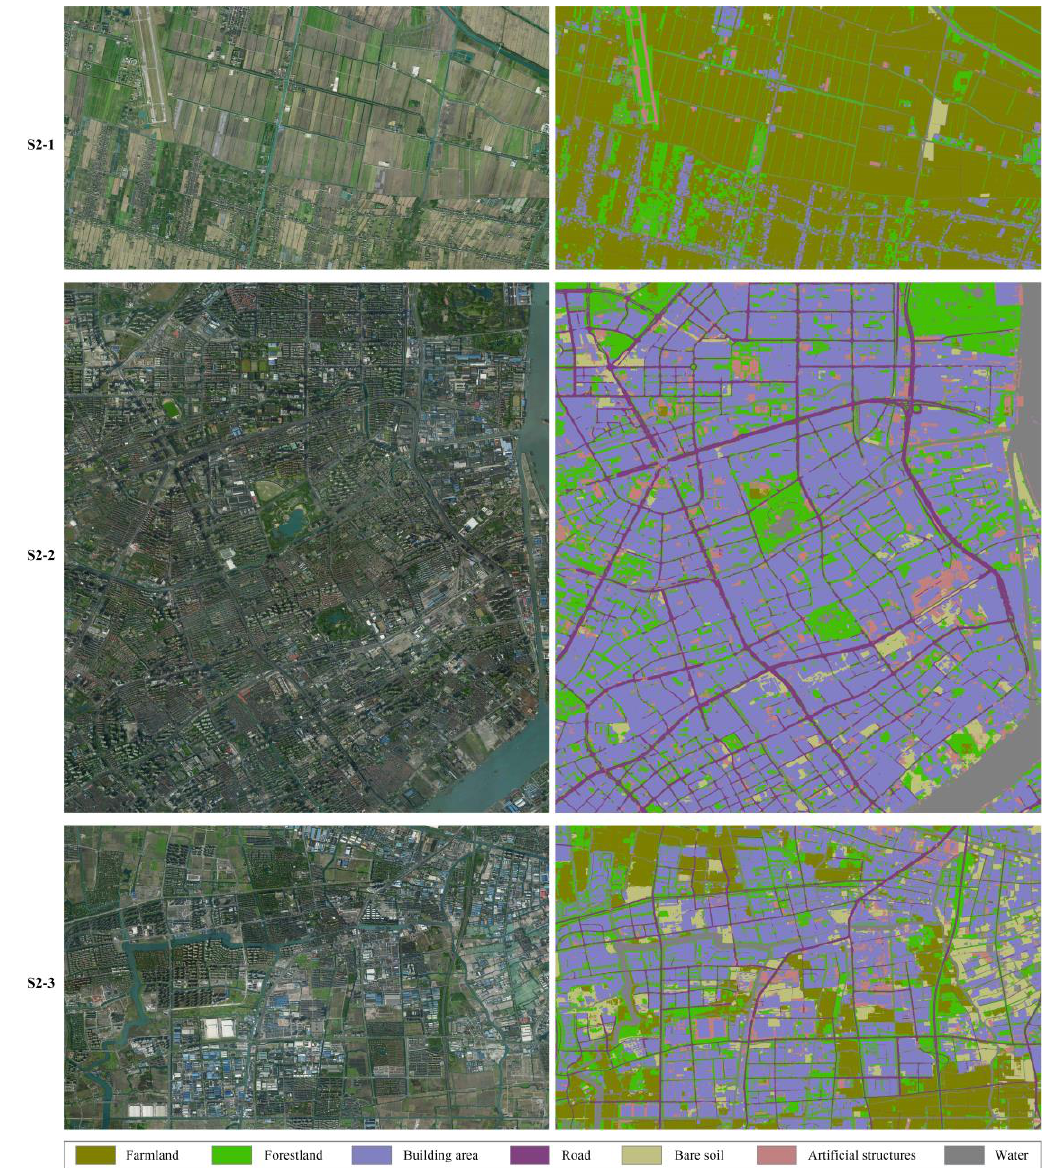
Figure 10. Urban land cover classification map using the proposed network.